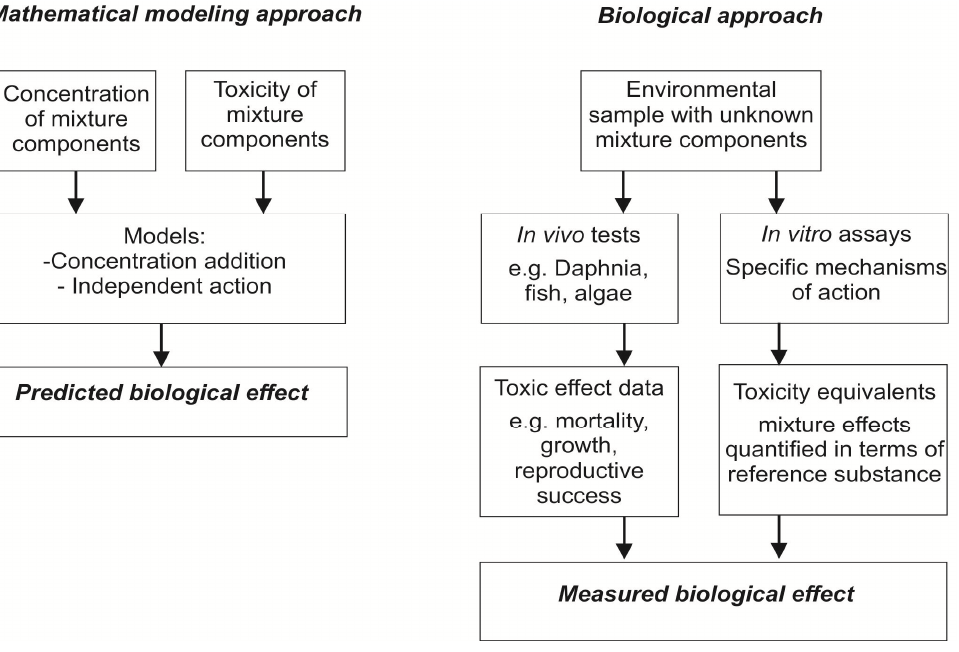
Figure 3. Two approaches to mixture toxicity assessment: effect prediction using mathematical modeling and single–substance toxicity data, and effect measurement using effect-based biological